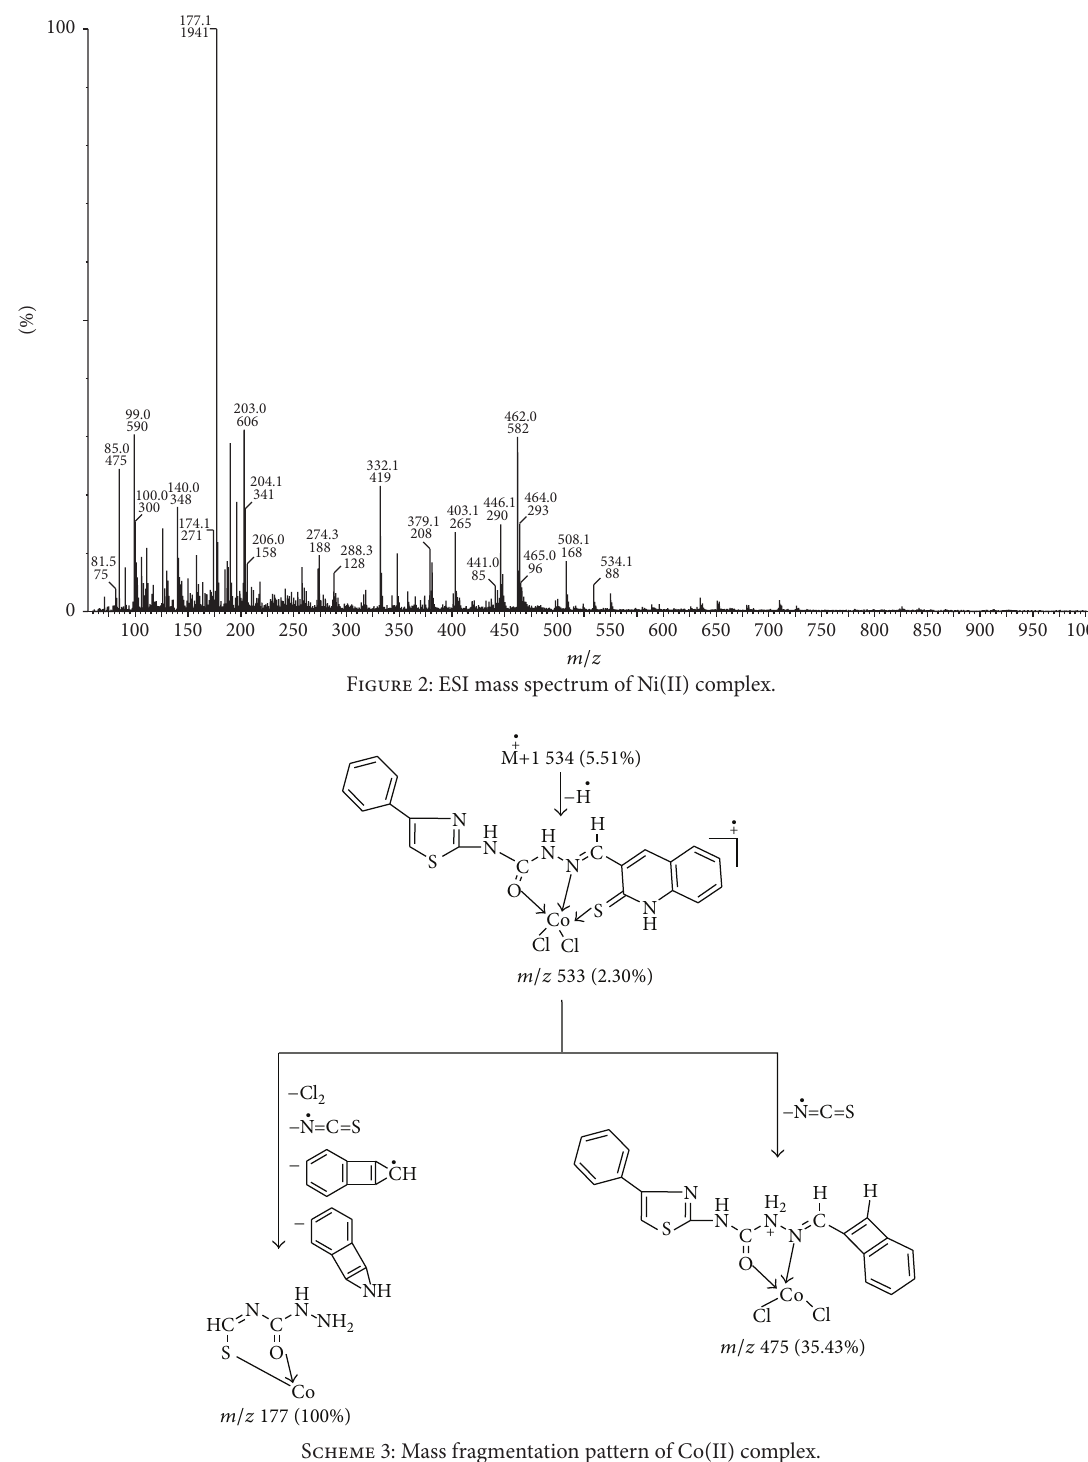
Scheme 3: Mass fragmentation pattern of Co(II)